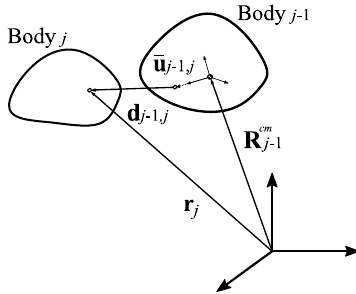
Figure 3. Schematic of relative bodies for recursive coordinate definition.